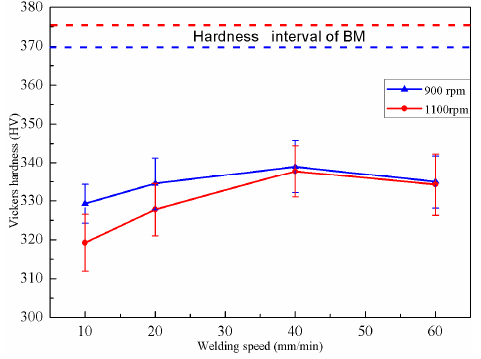
Figure 13. Effect of parameters on Vickers-hardness of FSWed Ti–6Al–4V joints.